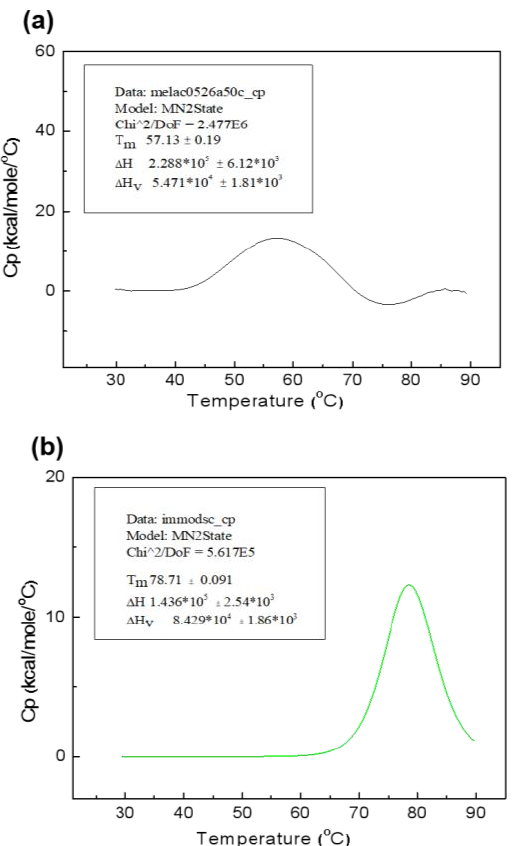
Figure 6. The curve of DSC. The melting temperature (T m ) and enthalpy of melting ( ∆ H l ) of free ( a ) and immobilized laccase ( b ).